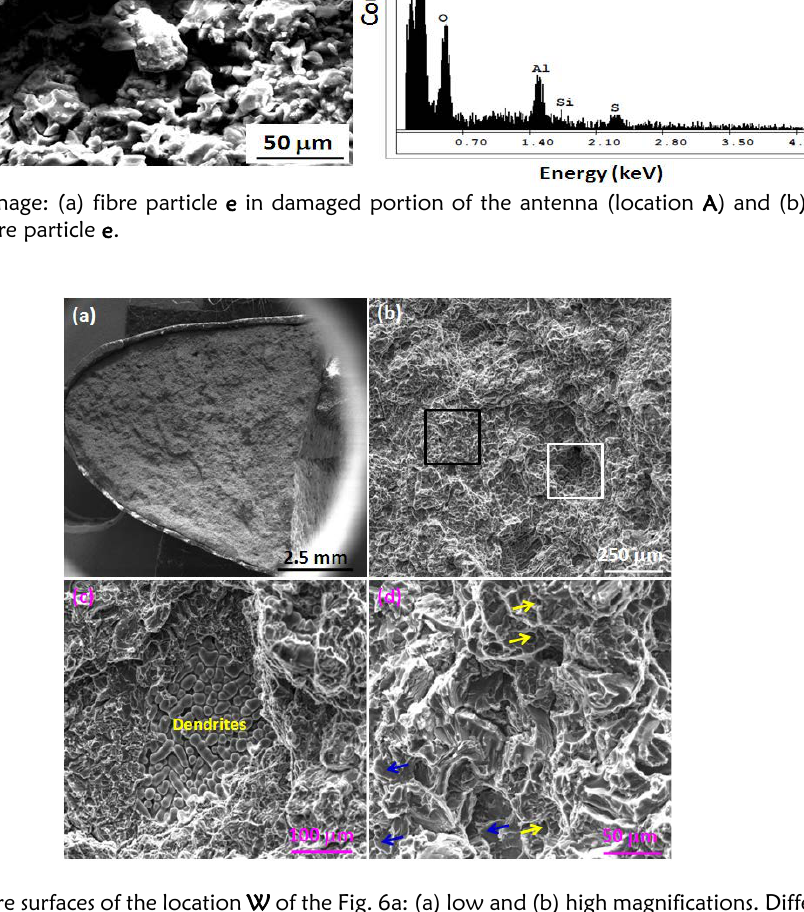
Figure 13: The fracture surfaces of the location W of the Fig. 6a: (a) low and (b) high magnifications. Different features in (b) are shown as square white and black boxes; SE SEM high magnification images of Fig. 13b corresponding to regions marked with: (c) white and (d) black square